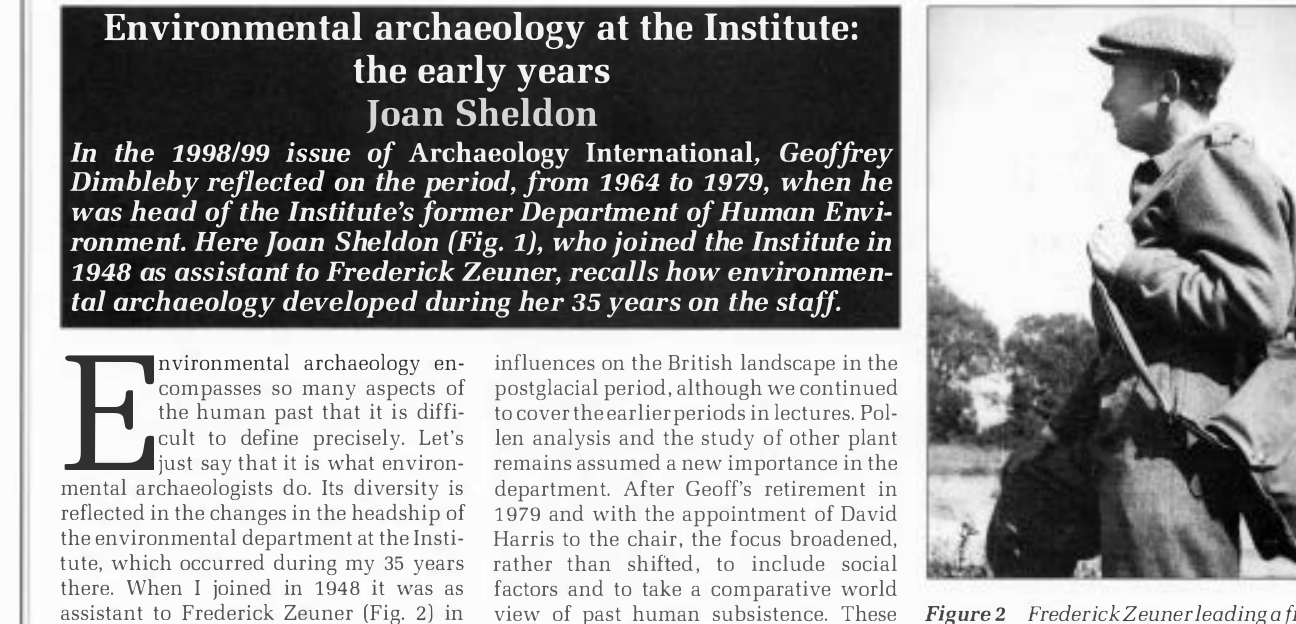
Figure 2 Frederick Zeuner leading a field excursion in the 1940s or 1950s; location